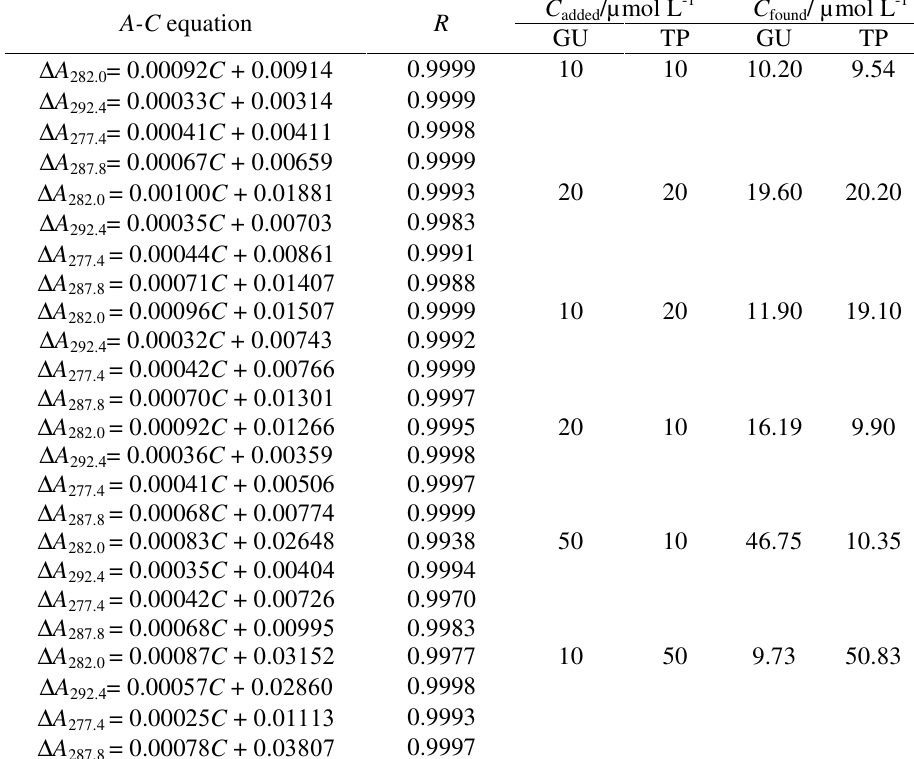
Table 1. Determination of Guaifenesin and theophylline in some synthetic mixtures.